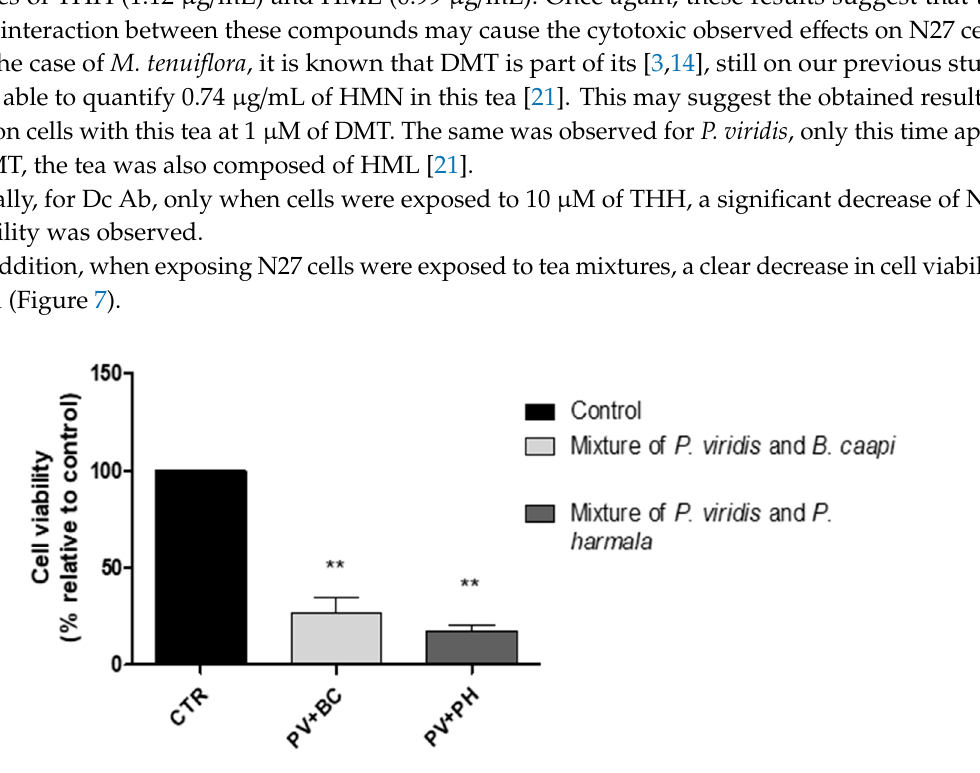
Figure 8. Protein levels when N27 cells are exposed during 24 h to HMN, THH, HML and DMT; CTR (control with untreated cells; 0.59 ± 0.08), HMN 0.00064 µM (0.65 ± 0.04), HMN 10 µM (0.19 ± 0.02), THH 0.00064 µM (0.56 ± 0.09), THH 10 µM (0.32 ± 0.05), HML 0.00512 µM (0.59 ± 0.04) and HML 10 µM (0.14 ± 0.0006); DMT 0.0008 µM (0.73 ± 0.02); DMT 1 µM (0.59 ± 0.03). n = 3, values are shown as mean ± SEM * indicates values that are significantly different from control p < 0.05, one-way analysis of variance followed by Dunnett’s multiple comparison test. CTR—control.